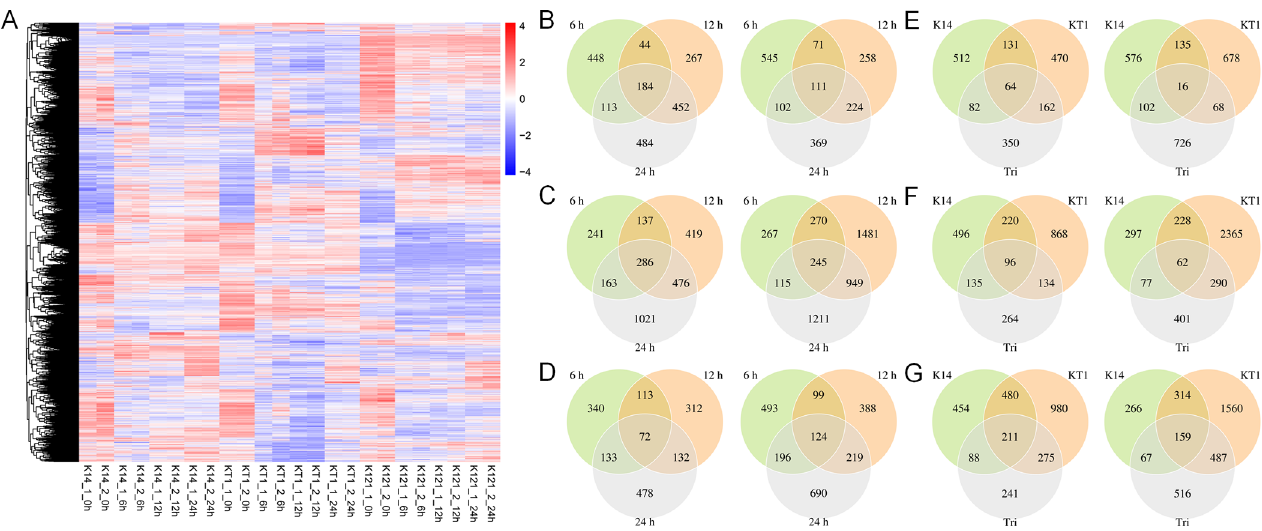
Fig 1. Heatmap clustering of unigenes and Venn diagram of differentially expressed genes (DEGs) in 24 samples. (A) Heatmap clustering of unigenes in 24 samples. (B-D) Venn diagrams of up-regulated and down-regulated DEGs under drought stress at 6 h, 12 h and 24 h in K14 (B), KT1 (C) and Tri (D). (E-G) Venn diagrams of up-regulated and down-regulated DEGs under drought stress in K14, KT1 and Tri at 6 h (E), 12 h (F) and 24 h (G). Left, up-regulated DEGs; right, down-regulated DEGs.